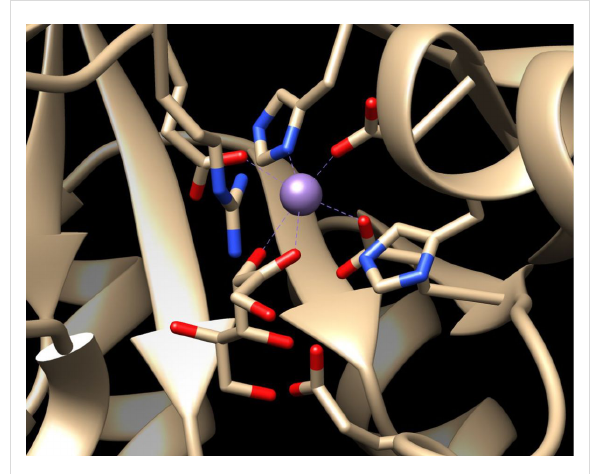
Figure 1: The active site in D-psicose 3-epimerase (DPEase) in the presence of D-fructose, showing the metal coordinating site and the substrate-binding site. The purple ball indicates the manganese(II) ion coordinating with key amino acid residues (Glu150, Asp183, His209, and Glu244) and the O-2 and O-3 of fructose. This figure was created using PDB File 2HK1